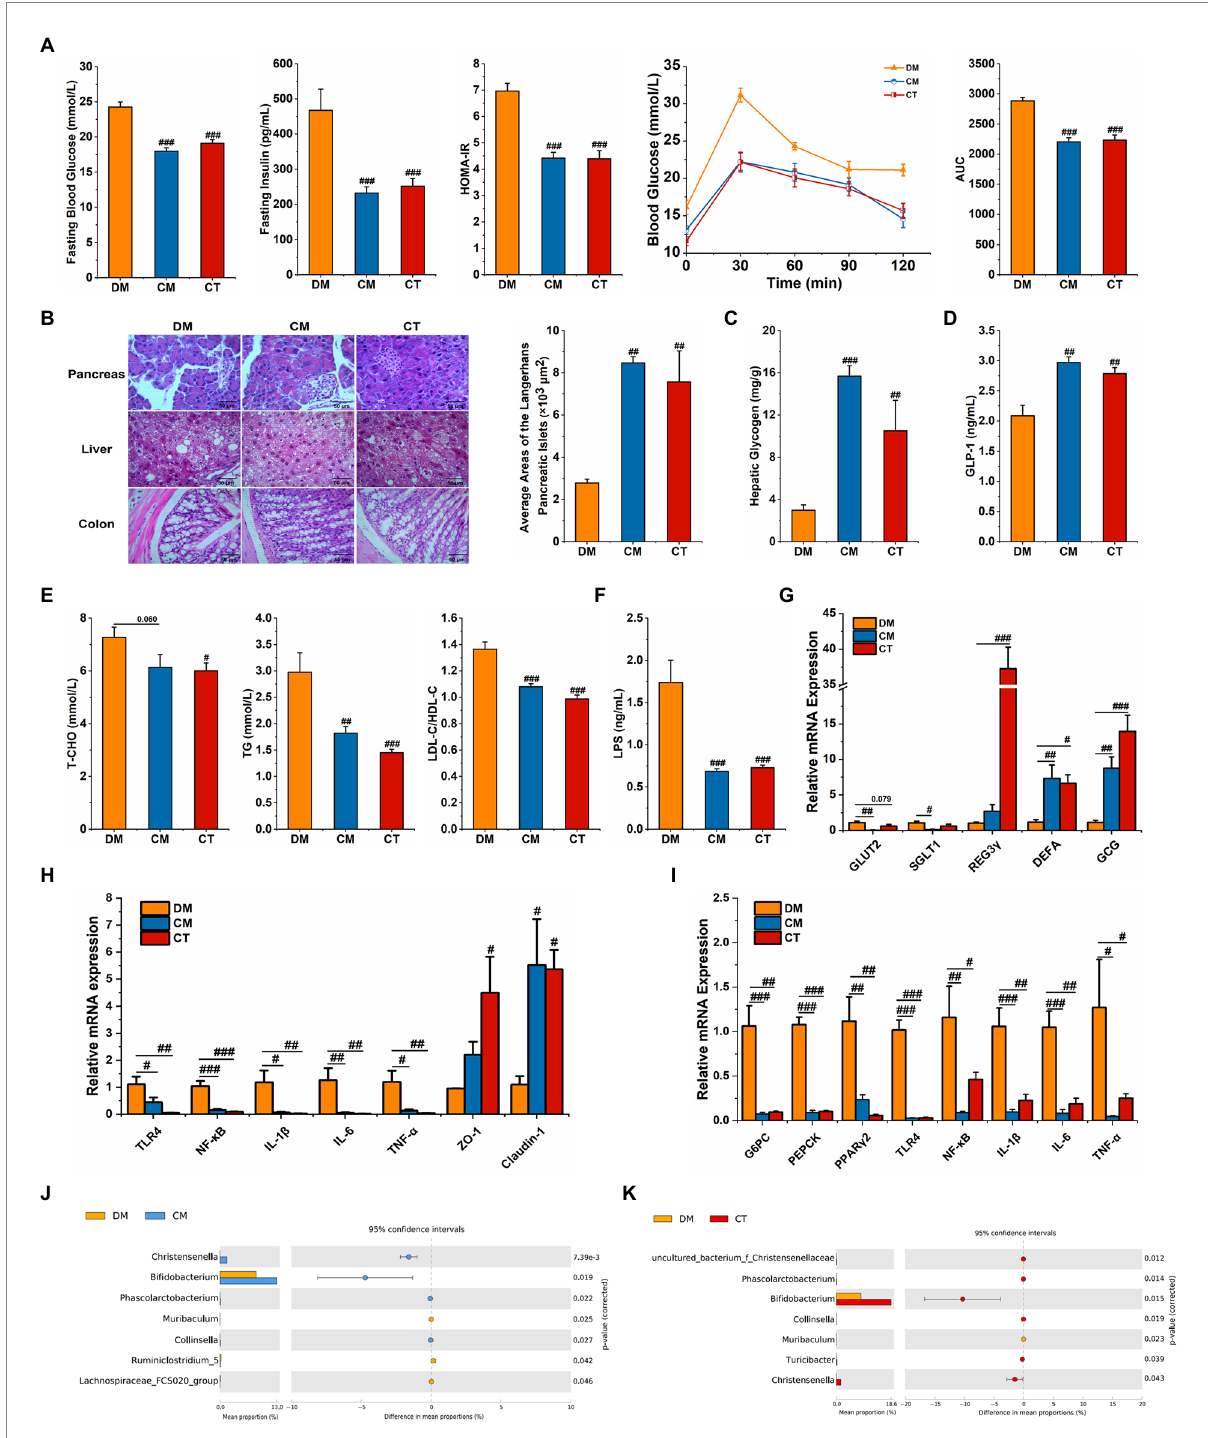
FIGURE 5 Supplementation with Christensenella ameliorated HFD and STZ induced type 2 diabetes. (A) Fasting blood glucose, serum level of insulin, homeostasis model assessment-insulin resistance (HOMA-IR), OGTT test, and area under the curve (AUC). (B) Morphological observation of pancreas (magnification, ×200, 50 μ m), liver (magnification, ×200, 50 μ m), colon (magnification, ×400, 50 μ m) with H&E staining, and average areas of the pancreatic islets of Langerhans. (C) Liver glycogen level. (D) Serum GLP-1 level. (E) Serum triglycerides, cholesterol, LDL-C/HDL-C levels. (F) Serum LPS level. (G) Relative mRNA expression of GLUT2, SGLT1, and GCG in ileum tissue. (H) Relative mRNA expression of TLR4, NF- κ B, IL-1 β , IL-6, TNF- α , ZO-1, and Claudin-1 in colon tissue. (I) Relative mRNA expression of G-6-Pase, PEPCK, TNF-a, TLR4, NF- κ B, IL-1 β , and IL-6 in the liver tissue. (J) Differential abundant feature of genus between the DM and the CM group. (K) Differential abundant feature of genus between the DM and the CT group. Data are expressed as mean ± SEM; Significant differences between the two groups were analyzed using Student’s t -test; One- way ANOVA was used to analyze statistical differences; Compare to DM: # p < 0.05; ## p < 0.01; ### p <